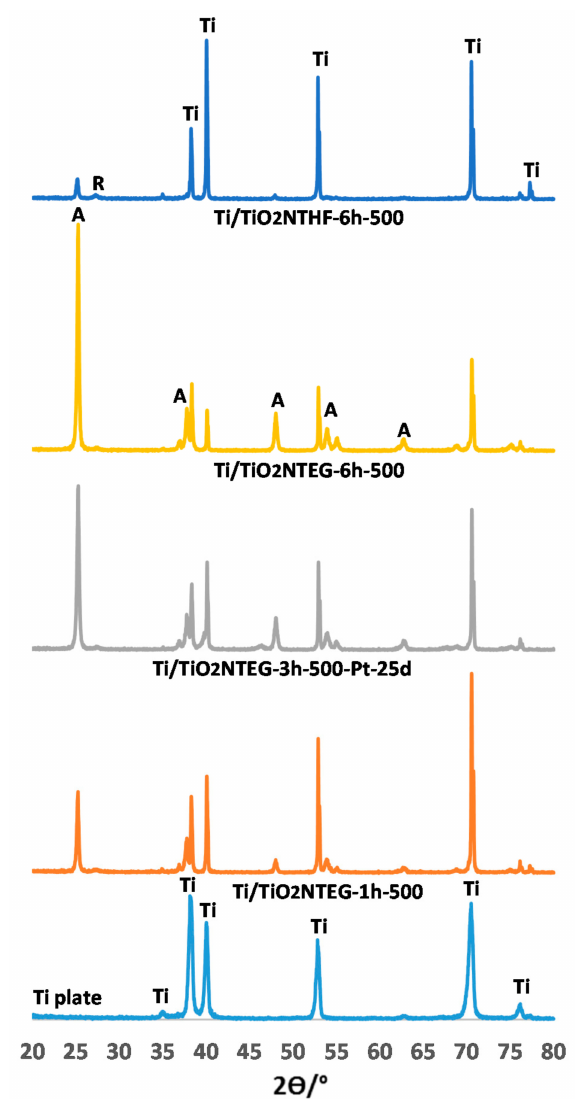
Figure 3. XRD patterns of the Ti/TiO 2 -NTEG-Xh-500